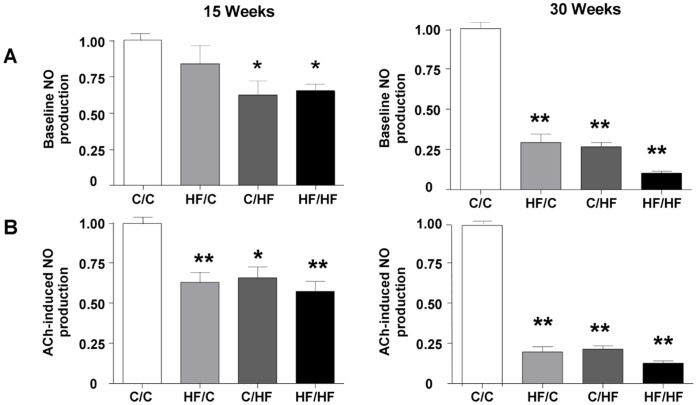
Impact of maternal HF-feeding on offspring NO production in femoral artery.(A) Basal NO production and (B) ACh-stimulated NO production in femoral arteries as detected by using 4,5-diaminofluorescein diacetate (DAF-FM) normalised to NO production by C/C offspring group (n = 3 per group). Data are expressed as mean ± SEM. Statistical comparisons were by ANOVA for the effects of maternal and offspring diet and age followed by comparisons using Dunnett’s Multiple Comparison Test for HF/C, C/HF and HF/HF vs. C/C. Values significantly different between high fat fed offspring groups and control offspring (C/C) at 15 or 30 weeks of age are indicated by * p<0.05, **p<0.01. (Please see Figure S4 for confocal images of DAF staining in the four offspring groups.).